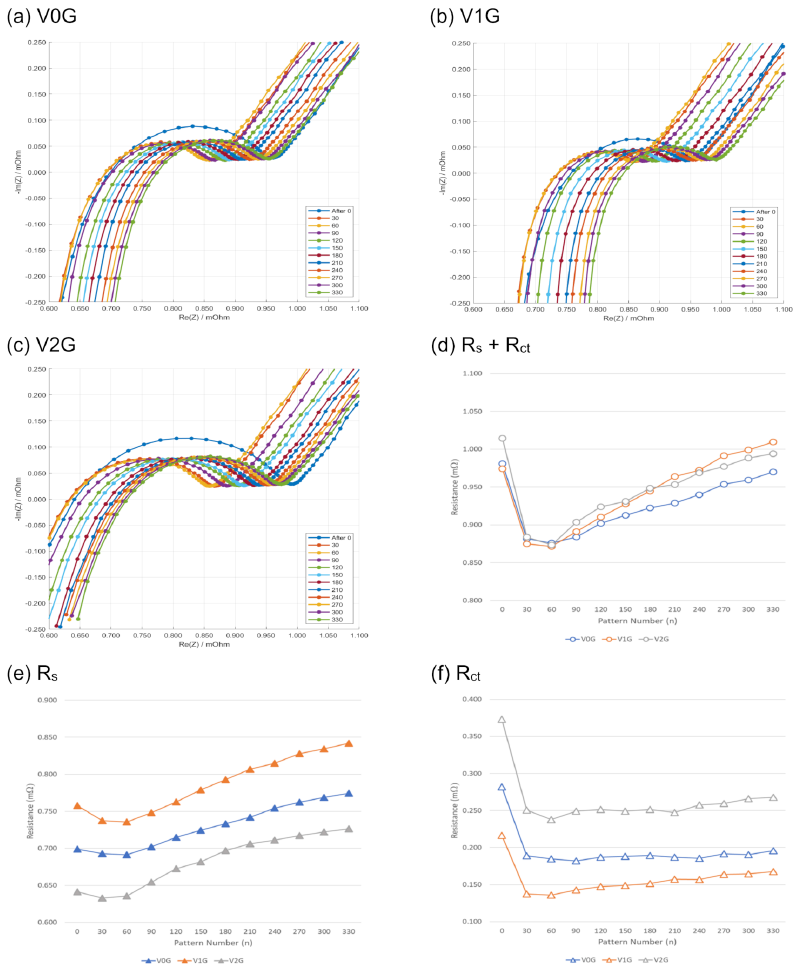
Figure 6. Post-pattern battery performance test: AC-impedance. ( a ) AC-impedance after V0G pattern, ( b ) AC-impedance after V1G pattern, ( c ) AC-impedance after V2G pattern, ( d ) Comparison of AC- impedance ( R s + R ct ) between patterns, ( e ) Comparison of R s between patterns, ( f ) Comparison of R ct between